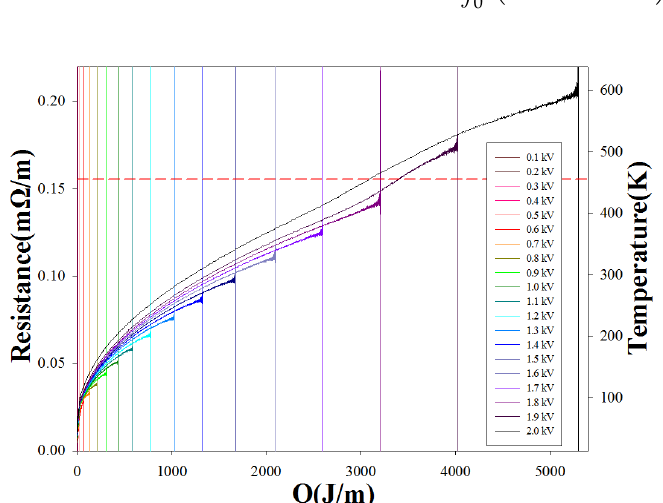
Figure 8. R–Q curves of sample 4 under impact.